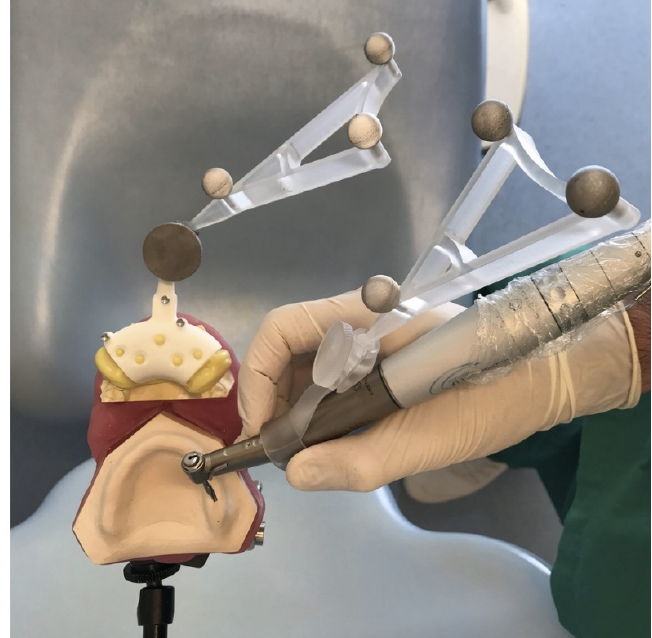
Figure 2. Drilling procedure. The reference tool is positioned on the model’s base and the tracking tools are placed on the reference tool and on the handpiece.